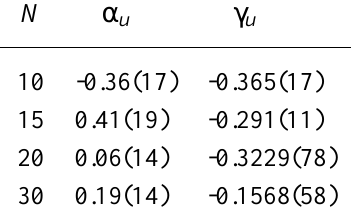
Table 2: Estimates for the parameters a